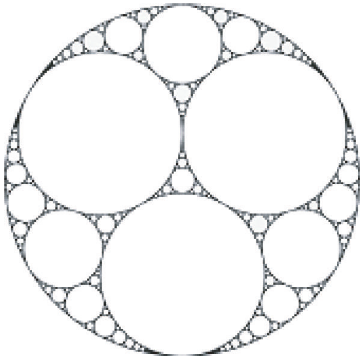
Figure 3.8. Apollonian